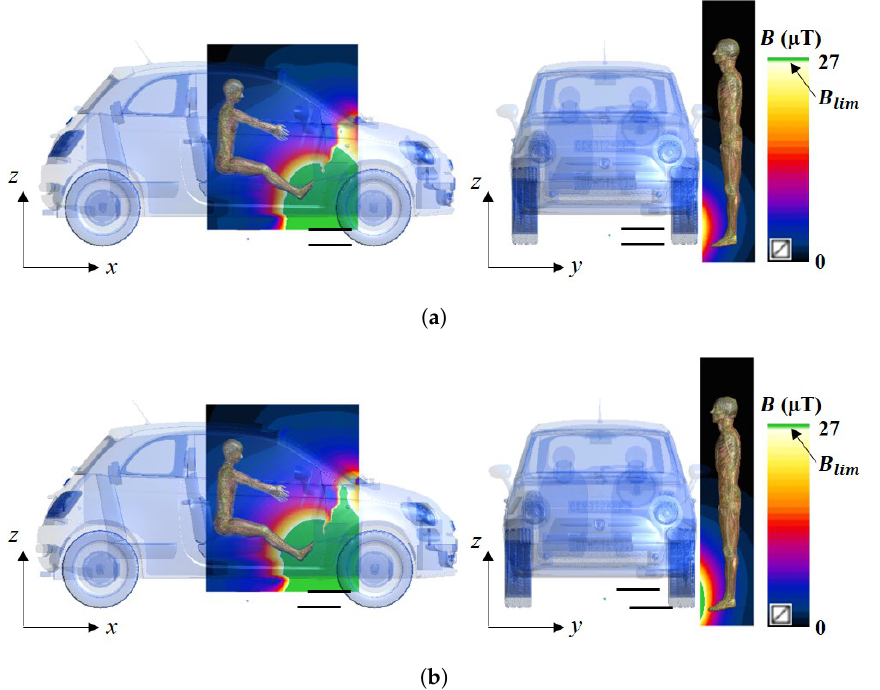
Figure 7. B -field distributions for the aligned ( a ) and misaligned ( b ) coil positions with the carbon fiber (CF)